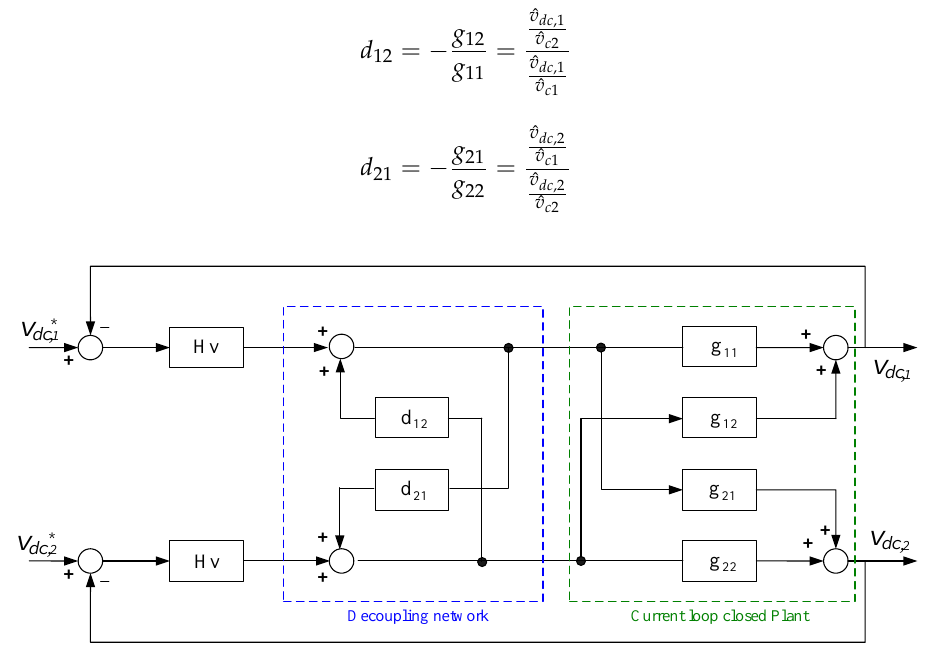
Figure 5. Inverted decoupling method of two-input and two-output system.